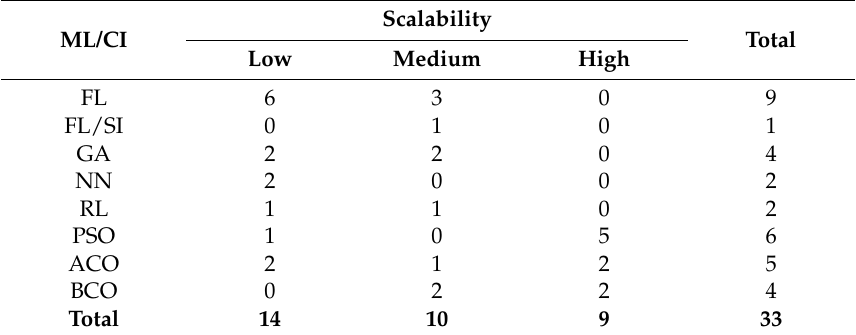
Table 2. Comparison of CI’s approaches according to the scalability.